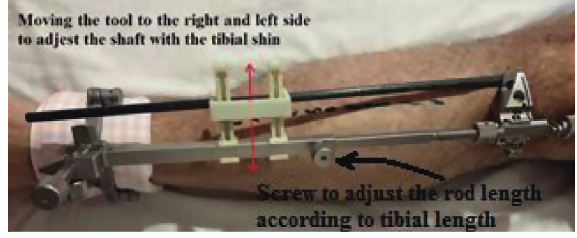
Figure 8: Fixing the tool properly.